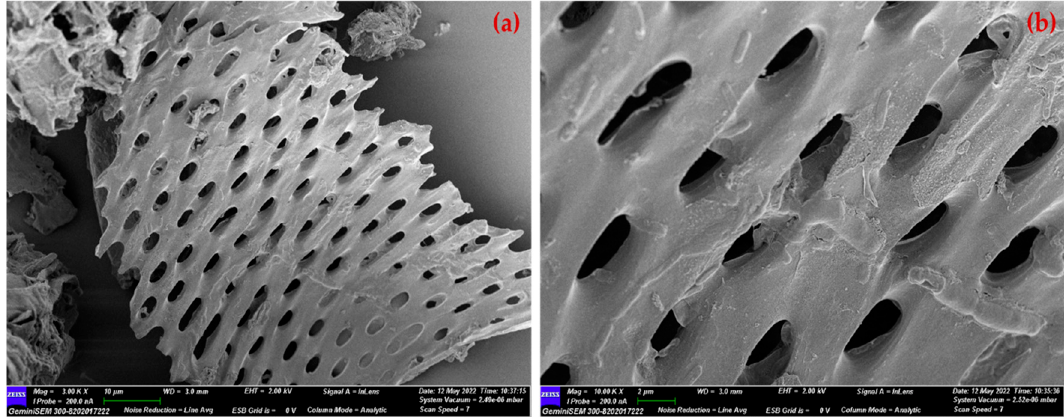
Figure 4. FESEM image of PSDB ( a ) at 3 KX ( b ) 10 KX magnification.